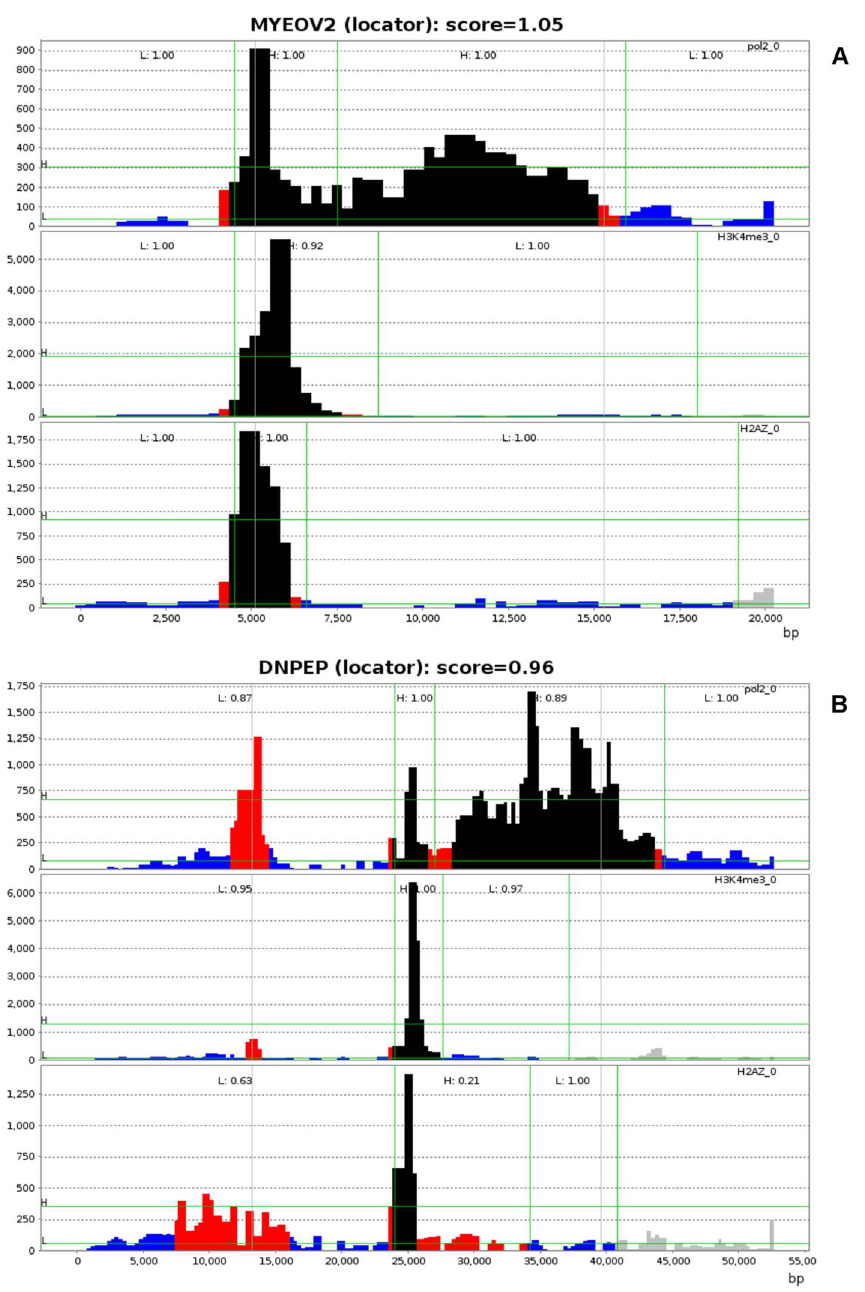
Figure 2. Locating the transcribed region of (A) MYEOV2 and (B) DNPEP . PolII, H3K4me3 and H2A.Z read counts are shown vertically with sample labels on the right. Sample data are the maximum of bin counts over all time points. The X-axis shows gene position in base-pairs (5 9 to 3 9 direction) and the Y-axis shows relative bin count. Green horizontal lines indicate Gaussian means of HMM states; the HMM state with lower mean is interpreted as class L state and the higher as class H state. Green vertical lines indicate segment boundaries assigned using simulated annealing. Gray vertical lines indicate gene locations obtained from Ensembl. The class and score of each segment is shown on top. For bin counts, black indicates a bin count inside class H segment that contributes positively to segment score and blue is analogous for class L ; red is a mismatching bin. Transcribed regions are obtained by concatenating the two H class segments of PolII.